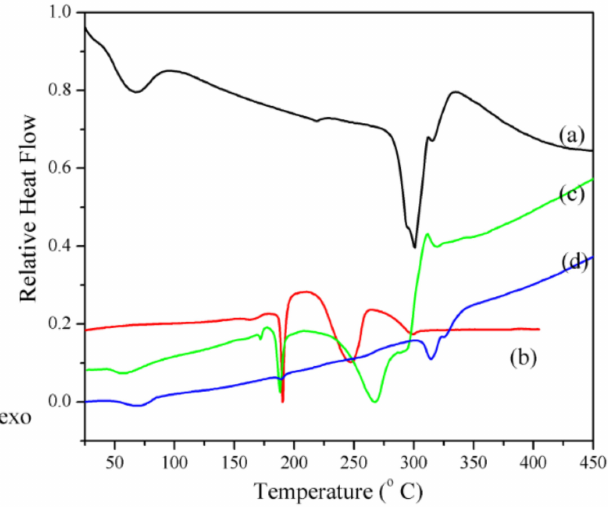
Figure 6. The relative heat flow DSC curves of (a) β -CD, (b) CBZ, (c) CBZ- β -CD physical mixture and (d) CBZ- β -CD inclusion